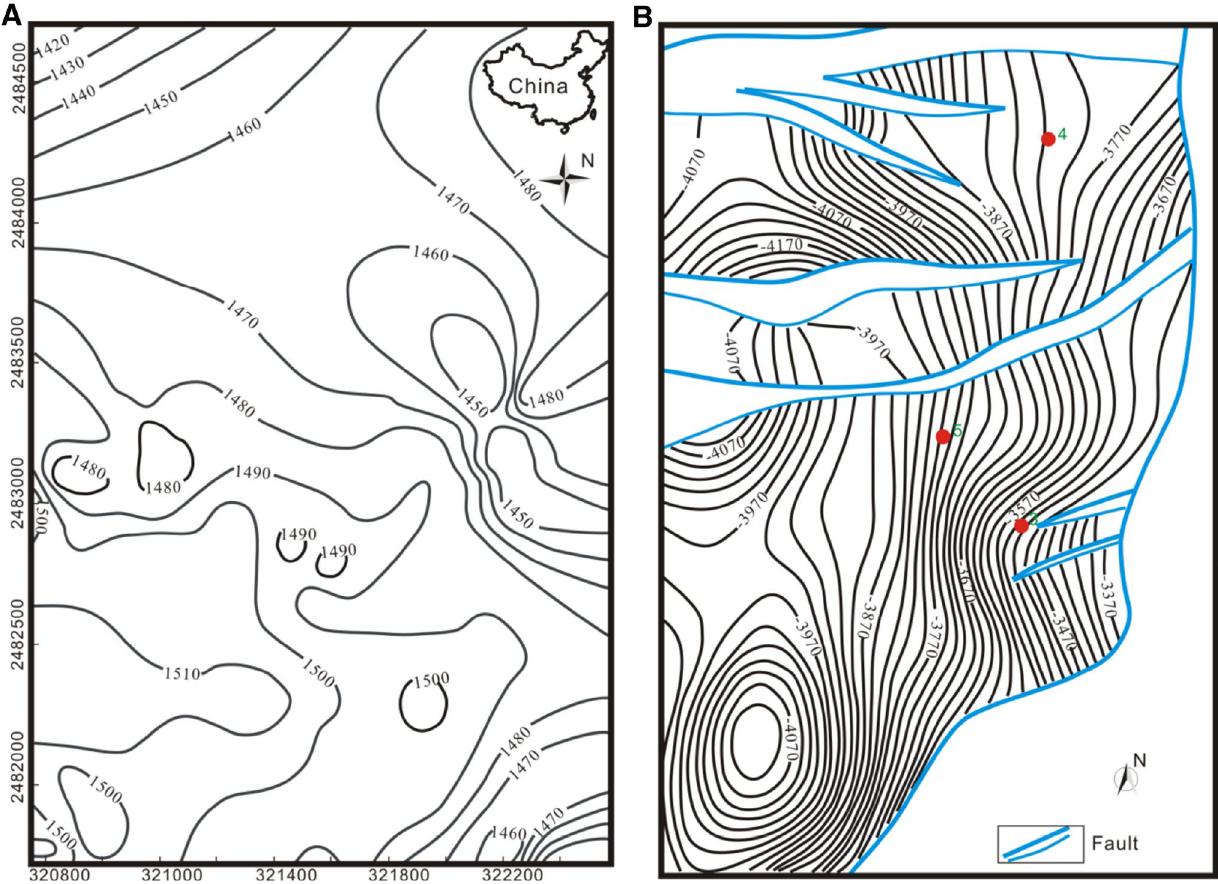
Fig. 1 Geological map of the study area. a The terrain map, showing the distribution trend of contour and the surface characteristics as well; b the top structure map of the third member of CPEDC, showing the distribution of the faults and the production wells in the study